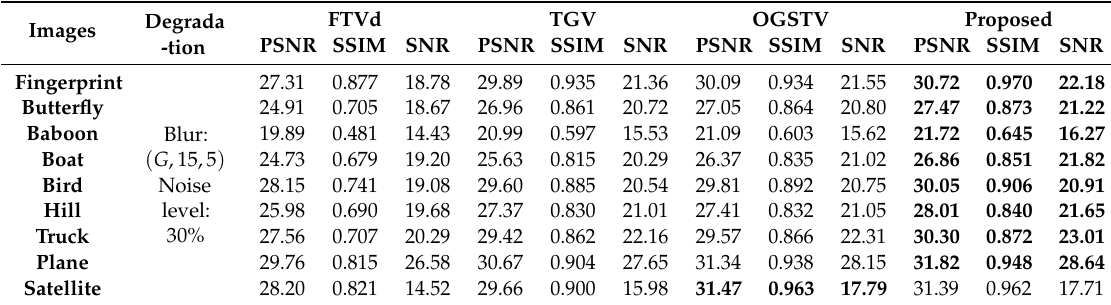
Table 3. Numerical results of PSNR (dB), SSIM, and SNR (dB) for the recovery of nine test images degraded with a Gaussian blur kernel ( G ,15,5 ) and 30% impulse